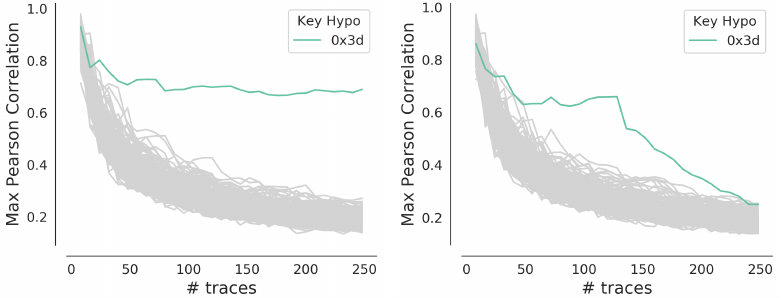
Figure 14: Maximum Correlation coefficients as a function of the number of traces in Step 4 with SNR=1.0 and N 15 = 0x00 (left) or N 15 = 0x80 (right).